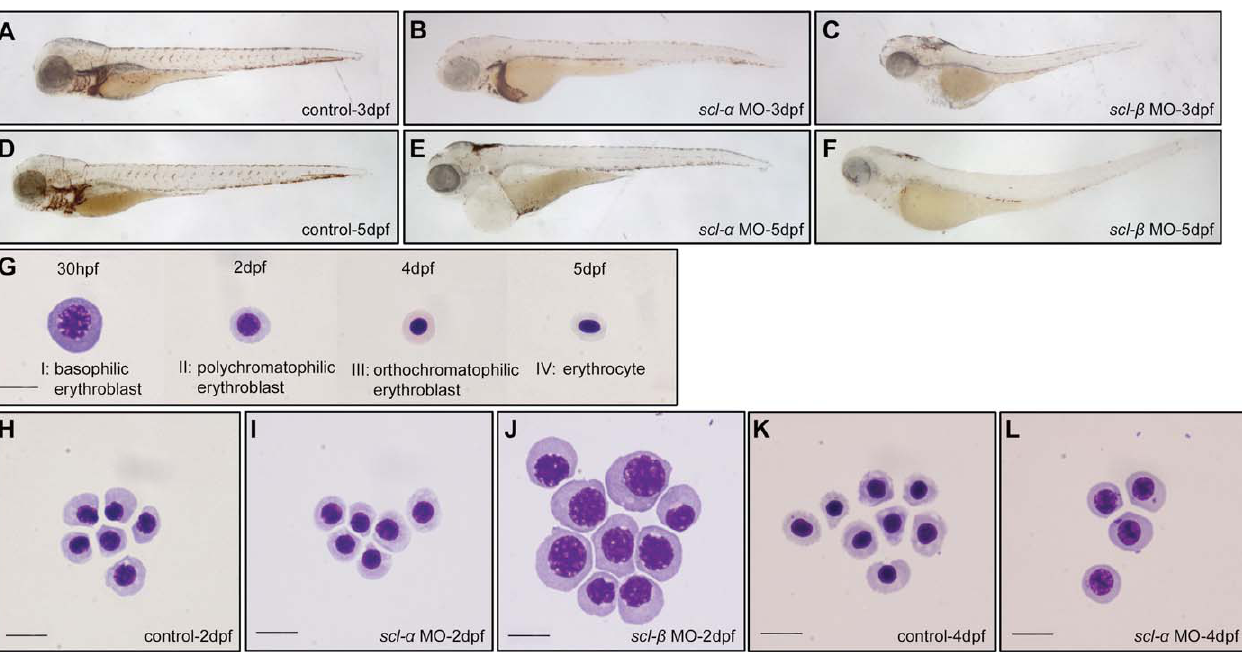
Figure 4. Requirement of scl- a and - b at Different Development Stages of Primitive RBC Differentiation (A–F) O-dianisidine staining of hemoglobin. At 3 dpf, expression of hemoglobin was severely reduced in scl- b morphants (C) compared to control embryos (A) and scl- a morphants (B). At 5 dpf, the o-dianisidine staining in both scl- a (E) and scl- b (F) morphants was dramatically decreased compared to that in control embryos (D). All embryos are in lateral view with anterior to the left. (G–L) May-Grunwald Giemsa staining of RBCs of different developmental stages (30 hpf to 5 dpf). Normal primitive RBCs at 30 hpf to 5 dpf can be classified into four main developmental stages (G): stage I, basophilic erythroblast; stage II, polychromatophilic erythroblast; stage III, orthochromatophilic erythroblast; and stage IV, mature erythrocyte. While RBCs from 2-dpf control embryos (H) and scl- a morphants (I) have